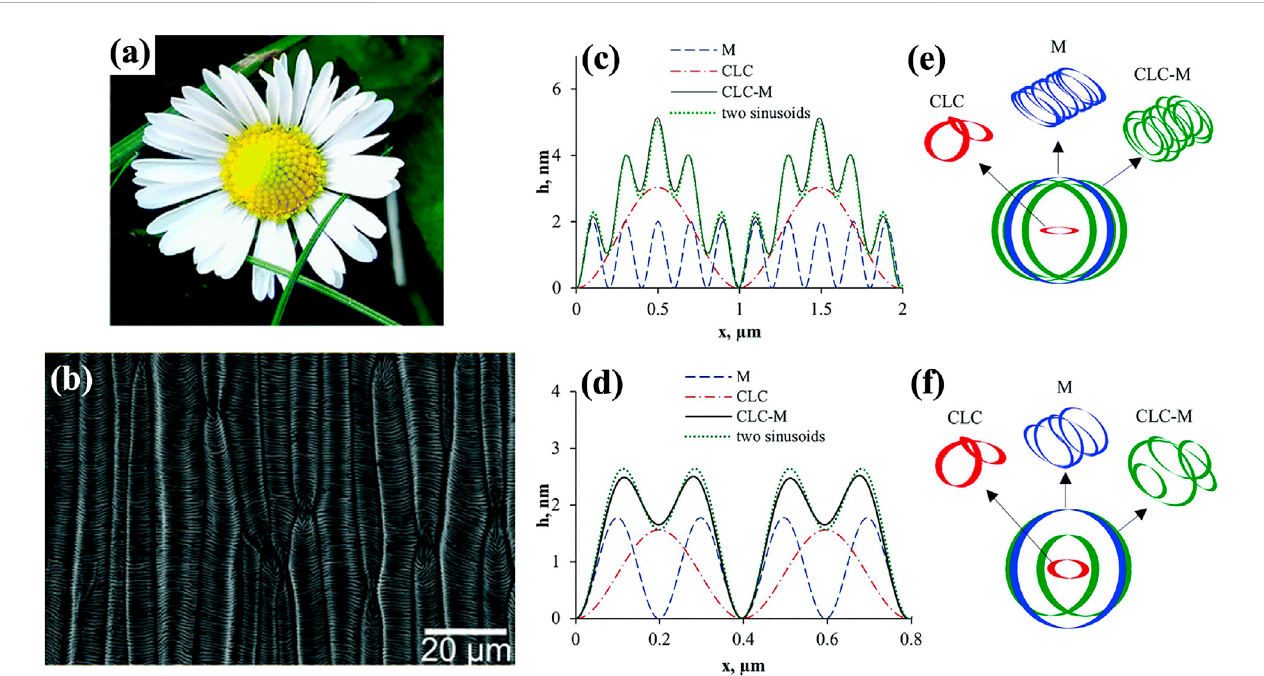
FIGURE 6 (A) and (B) Daisy Bellis perennis and the SEM micrograph. (C) To (F) , numerical results of surface pro fi le and the corresponding limit cycles and phase plots ofelasticmodel (M), anchoring model(CLC), and anchoring-elastic model (CLC-M) computed at W = − 1 ×10 − 4 J/m 2 , k c =5×10 − 18 J, T 0 = − 5×10 − 3 J/m 2 (C) and (E) , P 0 =1.98 μ m, ω =10. (D) and (F) , P 0 =0.79 μ m, ω =4. (A) and (B) are used with permission of Royal Society of Chemistry (2017), from (Schauer et al., 2017); permission conveyed through Copyright Clearance Center, Inc. (C – F) are reproduced from (Rofouie et al., 2017a) with permission from the Royal Society of